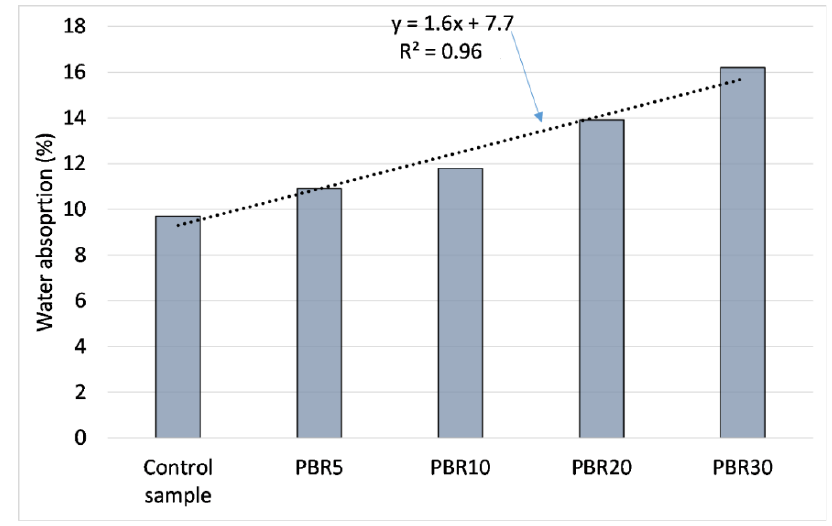
Figure 13. Water absorption for CR IPB at 28 days.